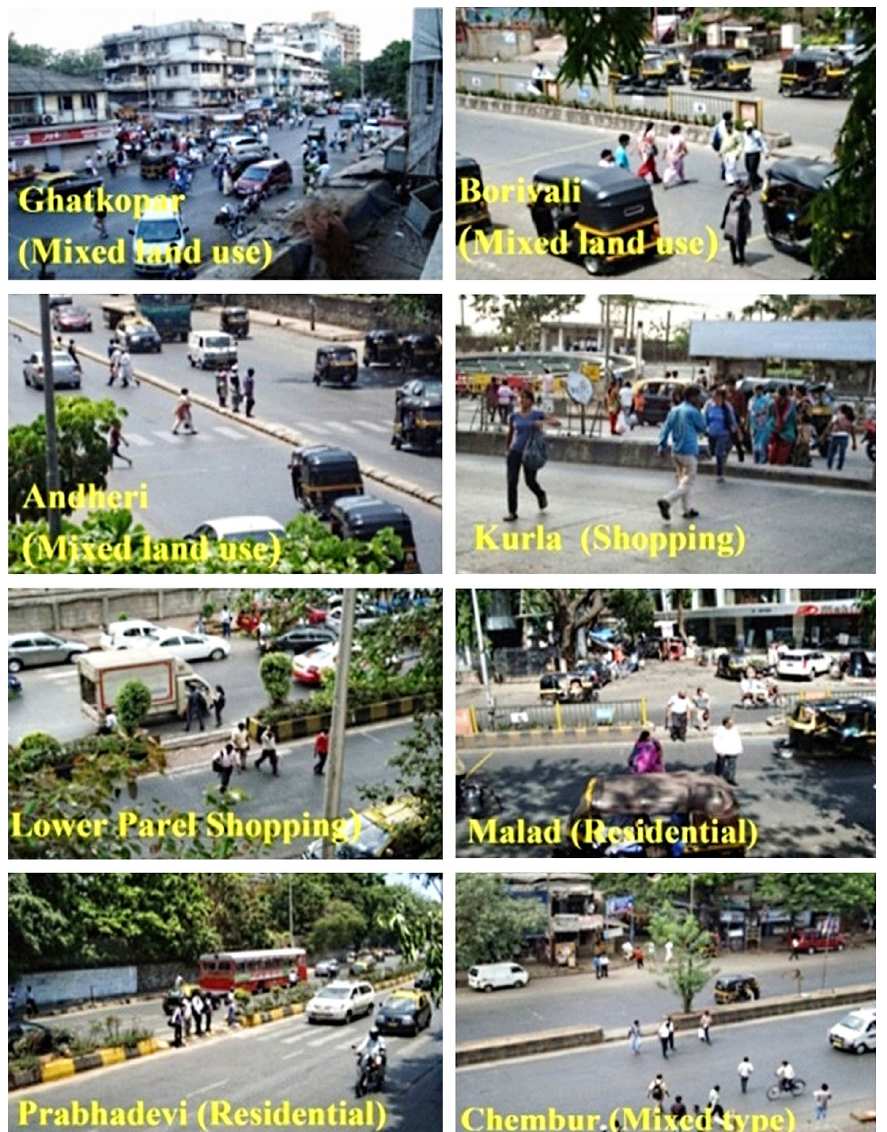
Fig. 1. The selected unprotected mid-block crosswalk